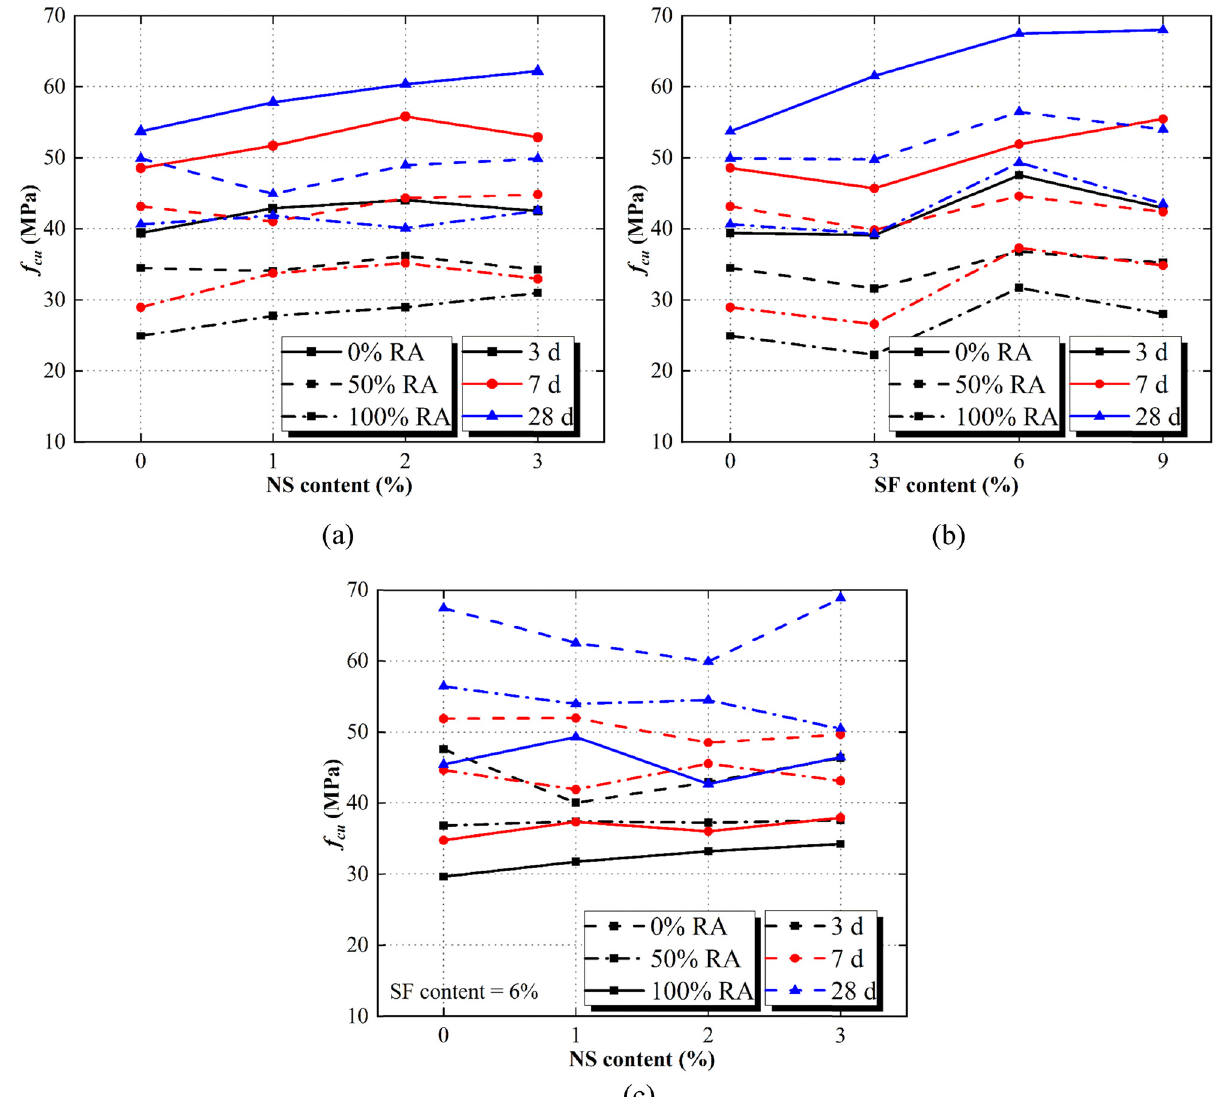
Figure 8: E ff ect of additives on the cubic compressive strength of concretes with ( a ) NS, ( b ) SF, and ( c ) NS and SF